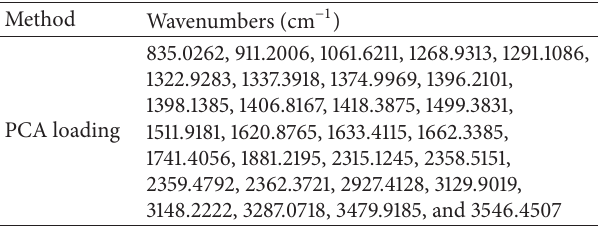
Table1:Theselectedwavenumbersbyprincipalcomponentanalysis